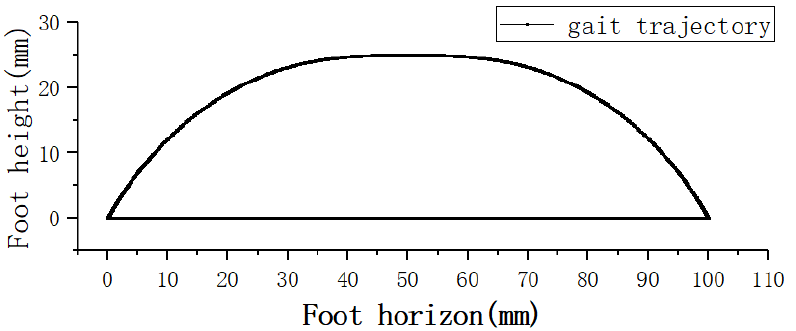
Figure 10. Gait trajectory of robot.